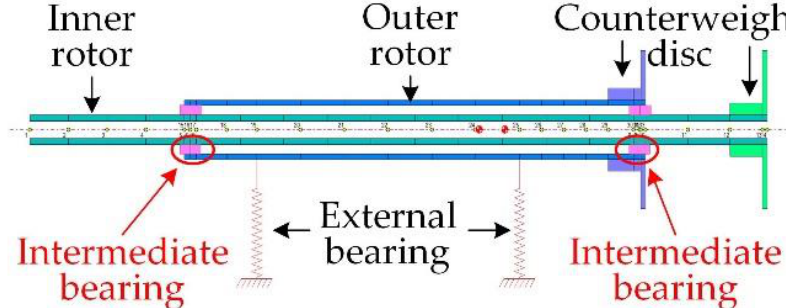
Figure 5. Finite element model.